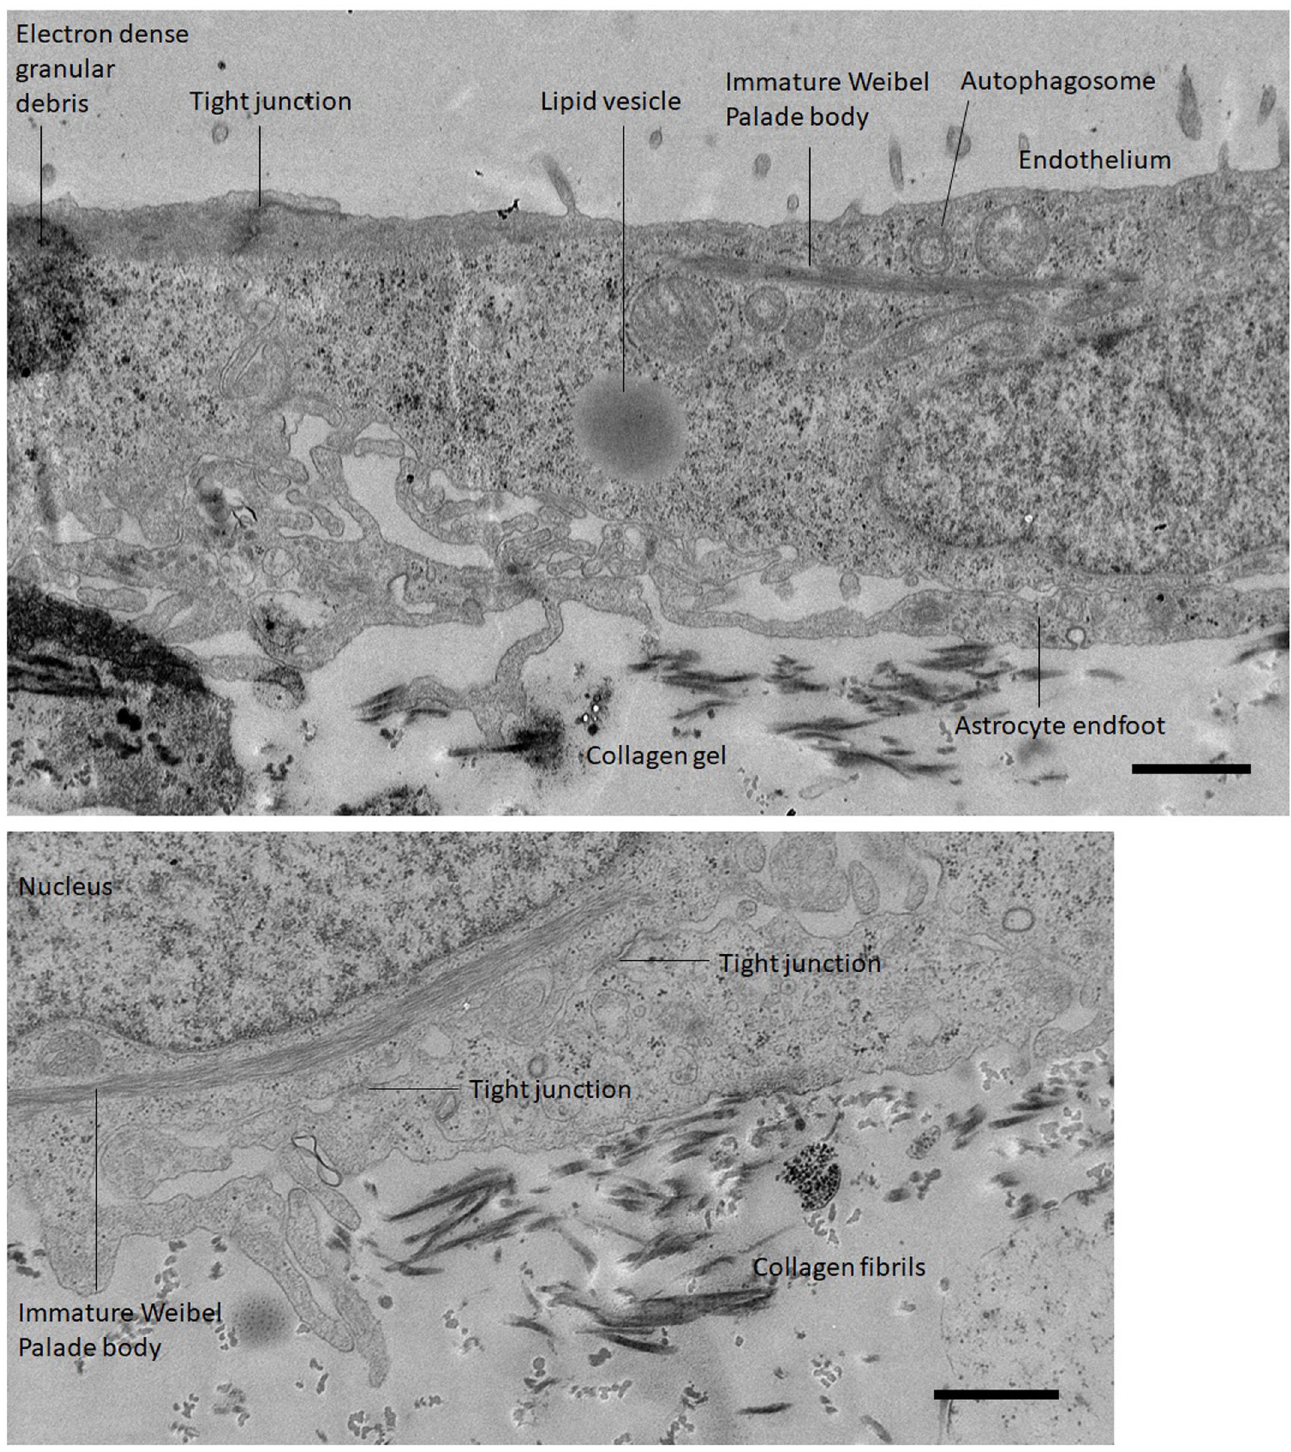
Fig 3. Transmission electron microscopy images of astrocytes in a collagen hydrogel with differentiated endothelial-like cells on the surface. A. A transverse section with the apical surface of the endothelium at the top. B. Transverse section showing the basal surface of the endothelial cells. Scale bars = 1 μ m.